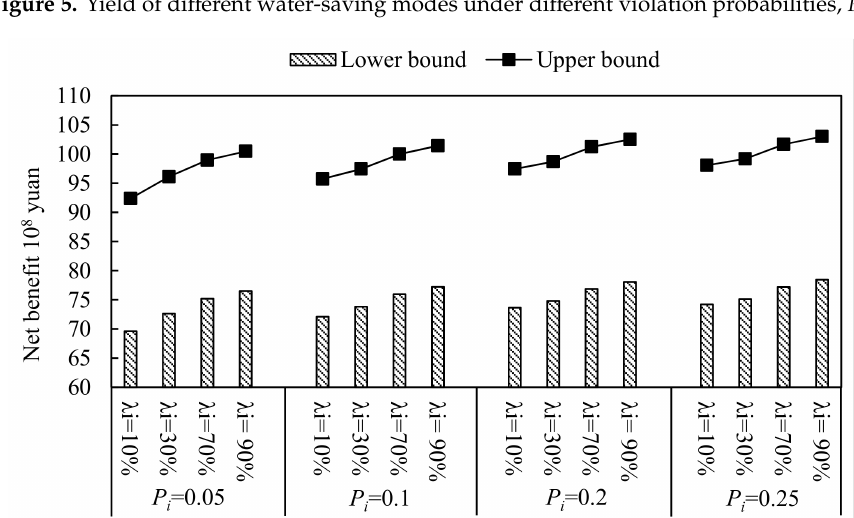
Figure 6. Net economic benefit of different water-saving modes under different violation probabilities, P i